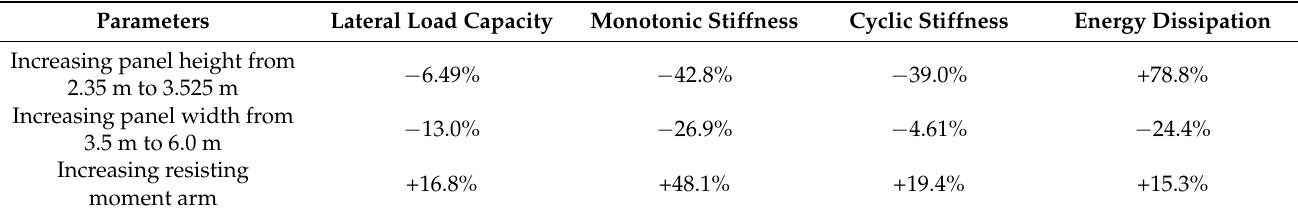
Figure 15. Horizontal in-plane lateral load versus displacement from validated numerical modeling with different log-foundation connection configurations under ( a ) monotonic loading; ( b ) cyclic loading. Table 2. Summary of parametric studies.